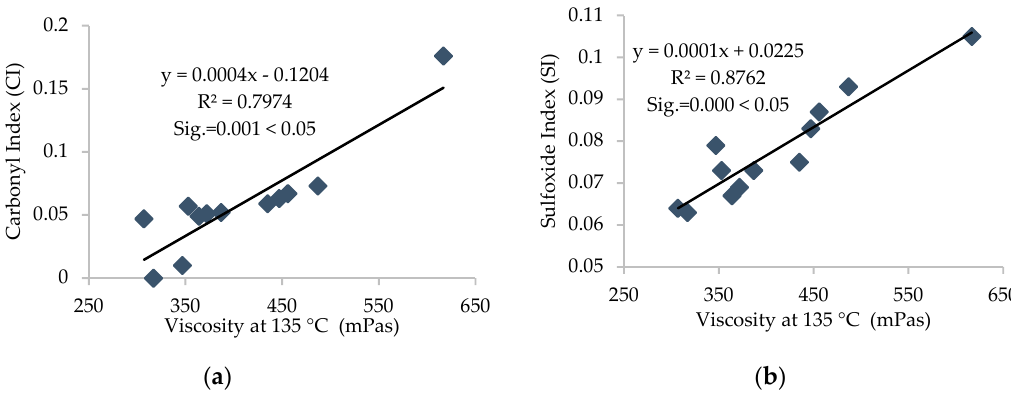
Figure 13. ( a ) Correlation between FTIR indices and ( b ) viscosity of all samples of binders.